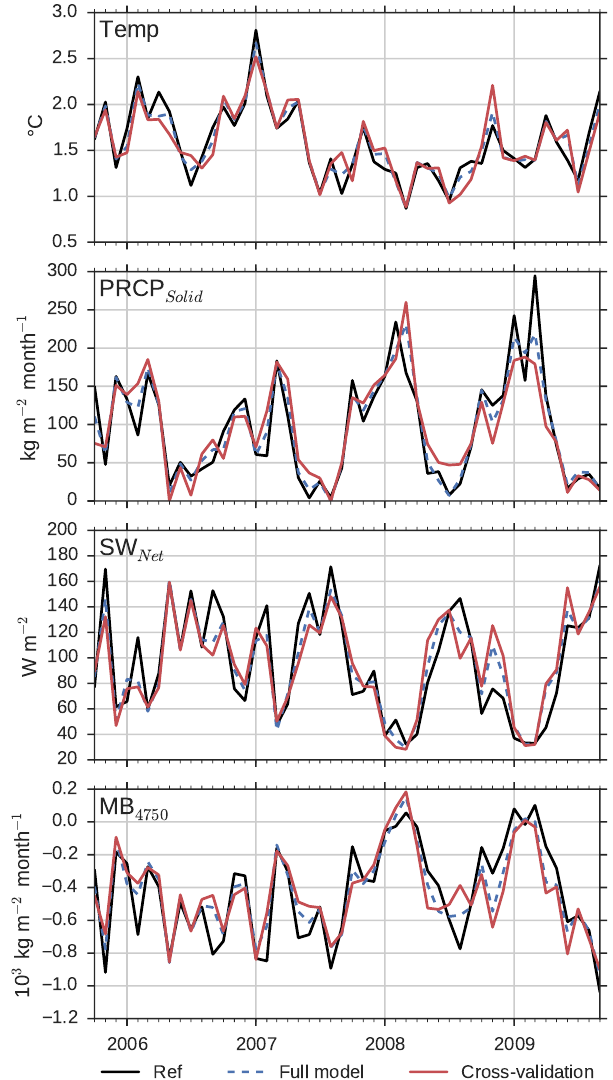
Figure 3. Time series of the reference data set (black), full down- scaling model (dotted blue) and out-of-sample cross-validation (red) during the calibration period. Shown are the variables air tem- perature, solid precipitation, net shortwave radiation, and MB at 4750ma . s . l